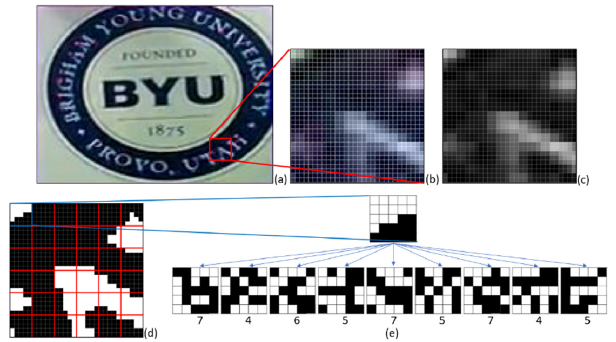
Figure 2. Diagram showing FRI (feature region of interest) selection and binarization. Followed by the similarity measure with nine example SBIs (synthetic basis images).